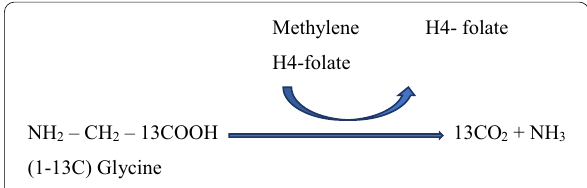
Fig. 1 Enzymatic reaction of GCS. Glycine breaks down into carbon dioxide, ammonia, and one carbon